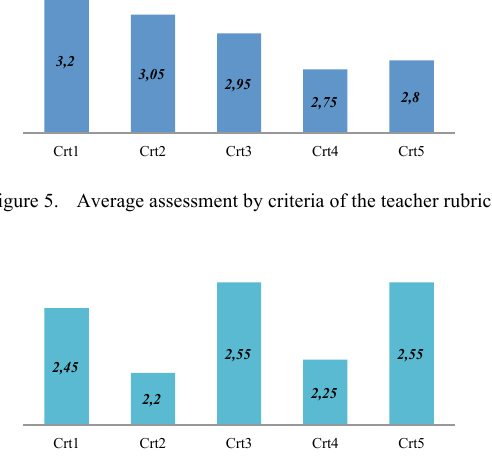
Figure 6. Average assessment by criteria of the student rubric.